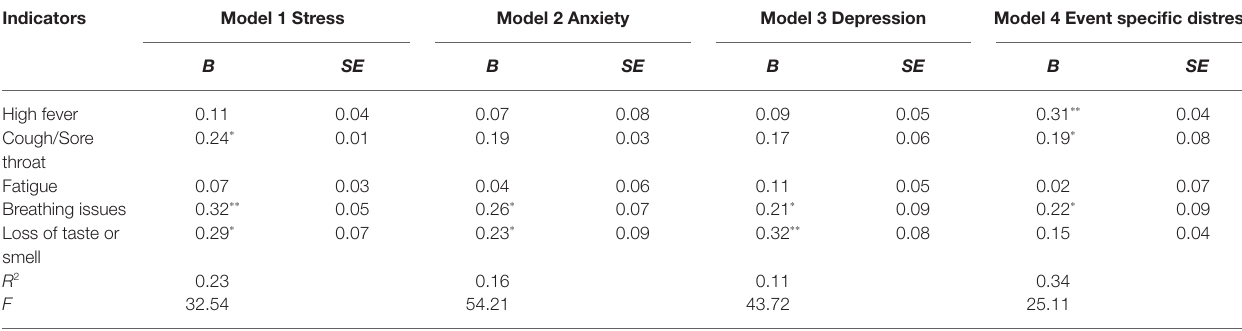
TABLE 2 | Connexion between the presence of psychical symptoms and psychological well-being and mental health of students. Indicators